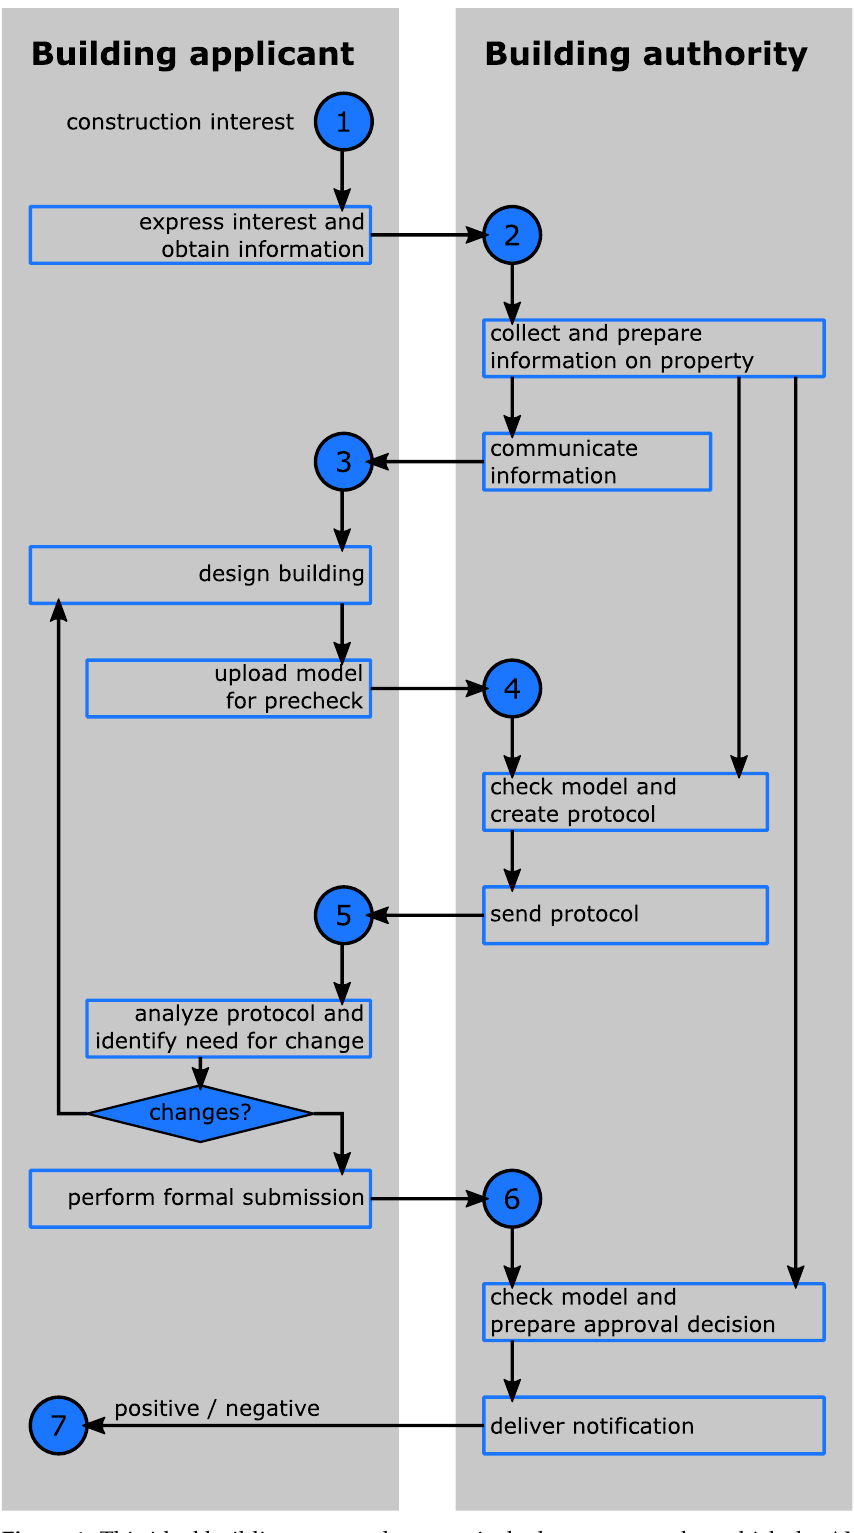
Figure 1. This ideal building approval process is the long-term goal to which the AMAzE project aims to